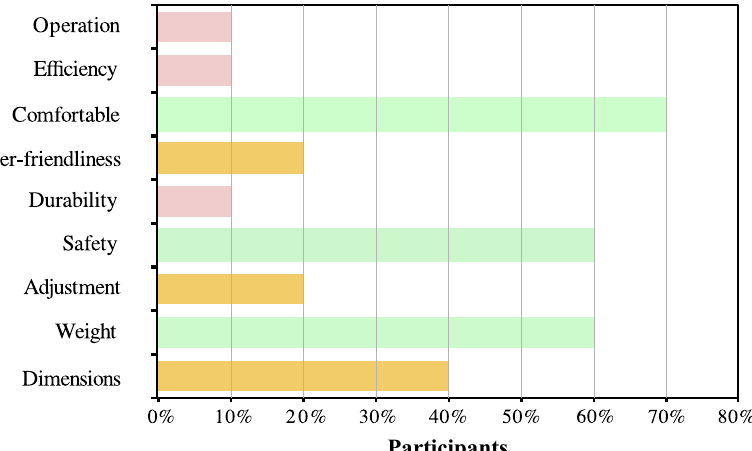
Figure 7. Results of the usability assessment through the Quebec User Evaluation of Satisfaction with assistive Technology (QUEST) test. The percentage of each topic refers to the number of participants who considered that characteristic as relevant.